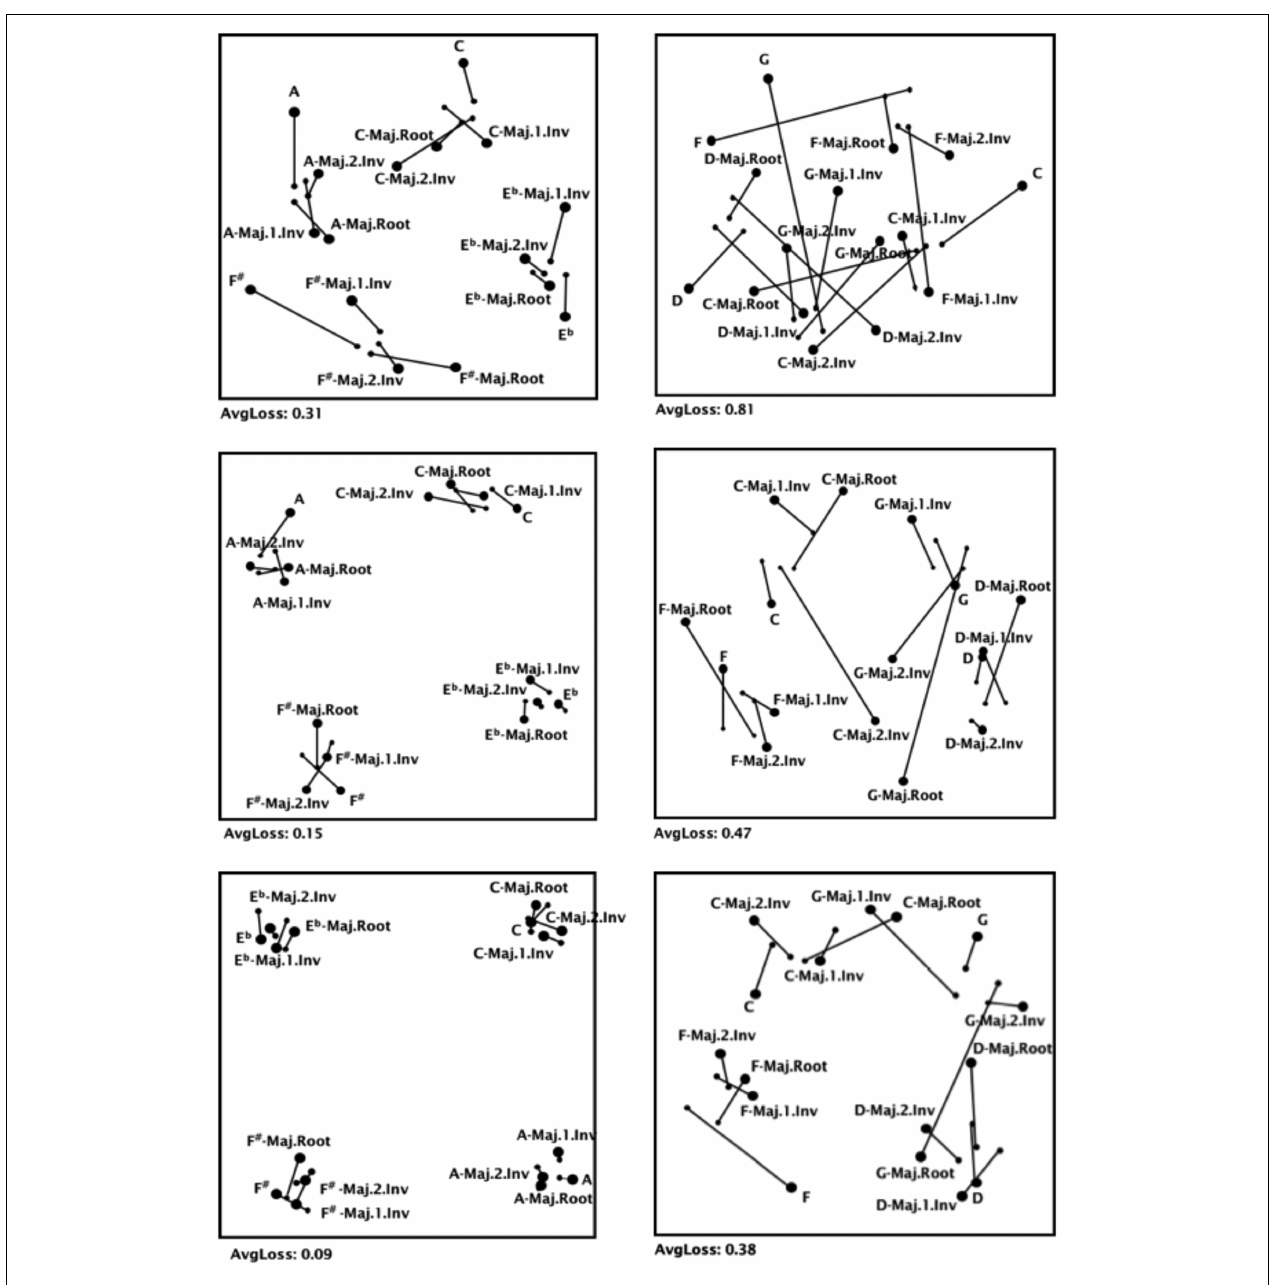
maps (small dots); connecting lines mark the corresponding deviations. For both representative “learning histories”, the AvgLoss (from top to bottom) is constantly decreasing; thus the novice maps consistently converge with the average expert maps. (Abbreviations: root = root position of a major chord; 1./2. Inv = first/second inversion of a major